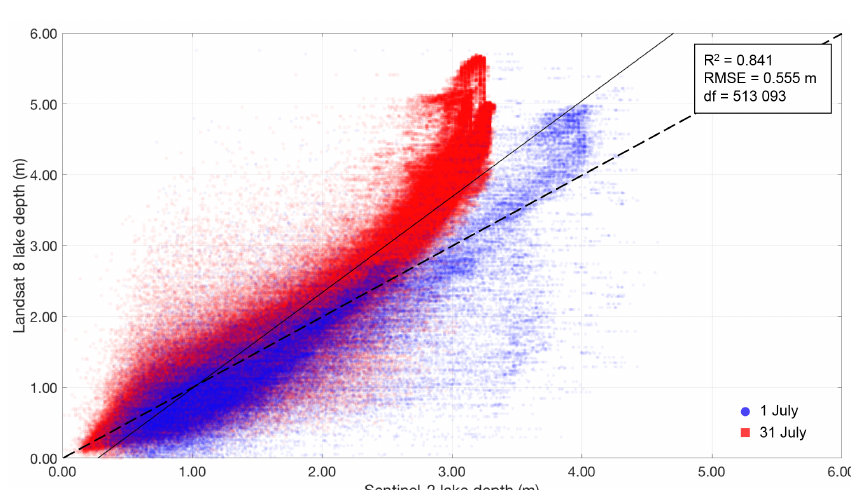
Figure 3. Comparison of lake depths calculated using the physically based method for Sentinel-2 (with the red band) and for Landsat 8 (with the average depths from the red and panchromatic bands). Degrees of freedom (“df” in this figure) = 513093. The solid black line shows an ordinary least-squares (OLS) linear regression and the dashed black line shows a 1:1 relation. The R 2 value indicates that the regression explains 84.1% of the variance in the data. The RMSE of 0.555m shows the error associated with calculating the Sentinel-2 lake depths using this